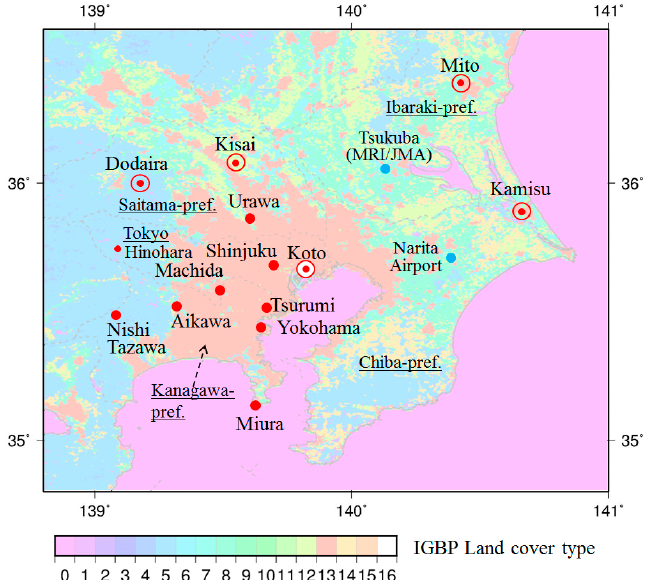
Figure 1. Locations of observation sites. Closed red circles with an open circle represent sites for which hourly data are available. Closed red circles represent older sites. Closed blue circles denote the locations of Meteorological Research Institute of the Japan Meteorological Agency (MRI/JMA) and Narita Airport, where tower data and vertical profiles of CO 2 concentration are available, respectively. Names of prefectures are underlined. Background colors represent the International Geosphere- Biosphere Programme (IGBP) land cover types (0: water, 1: evergreen needleleaf forest, 2: evergreen